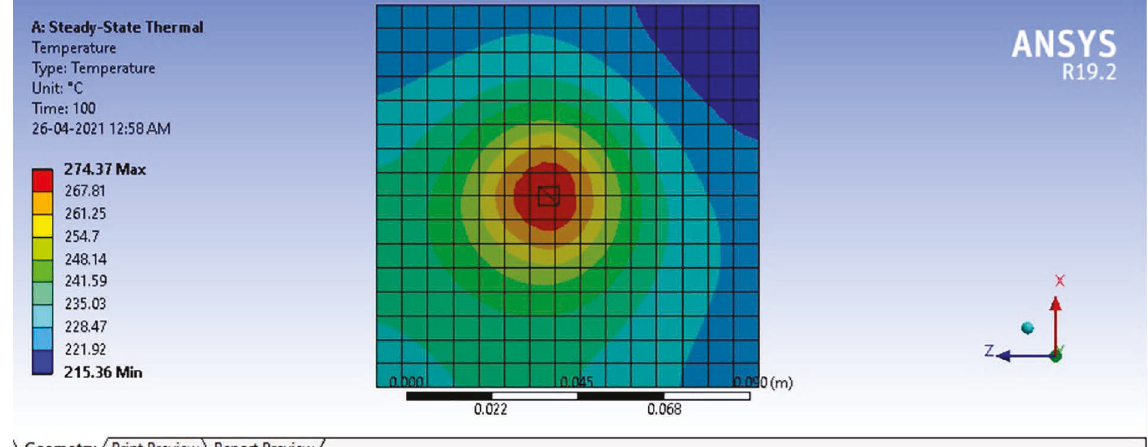
Figure 11: Temperature distribution with a hardened H13 steel tool round pin profile when tool temperature was 272.9 °